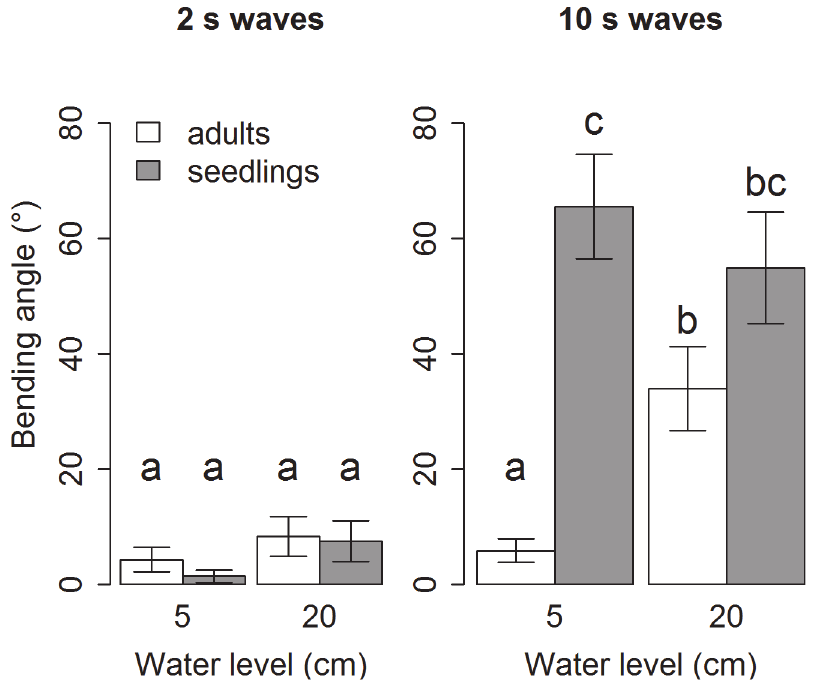
Fig 6. Averages and SE of measured final bending angle of plant stems (°). Significant differences as resulting from a three-way ANOVA followed by a post-hoc Tukey ’ s HSD are indicated by different